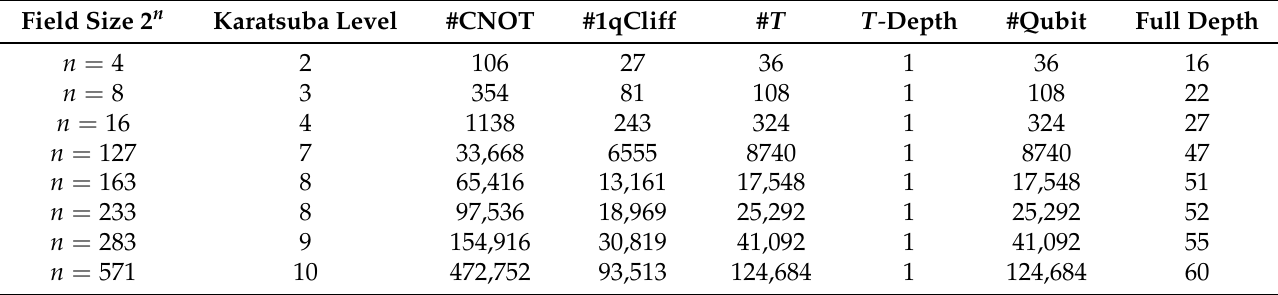
Table 3. Resources required for quantum multiplication at T -depth one using AND